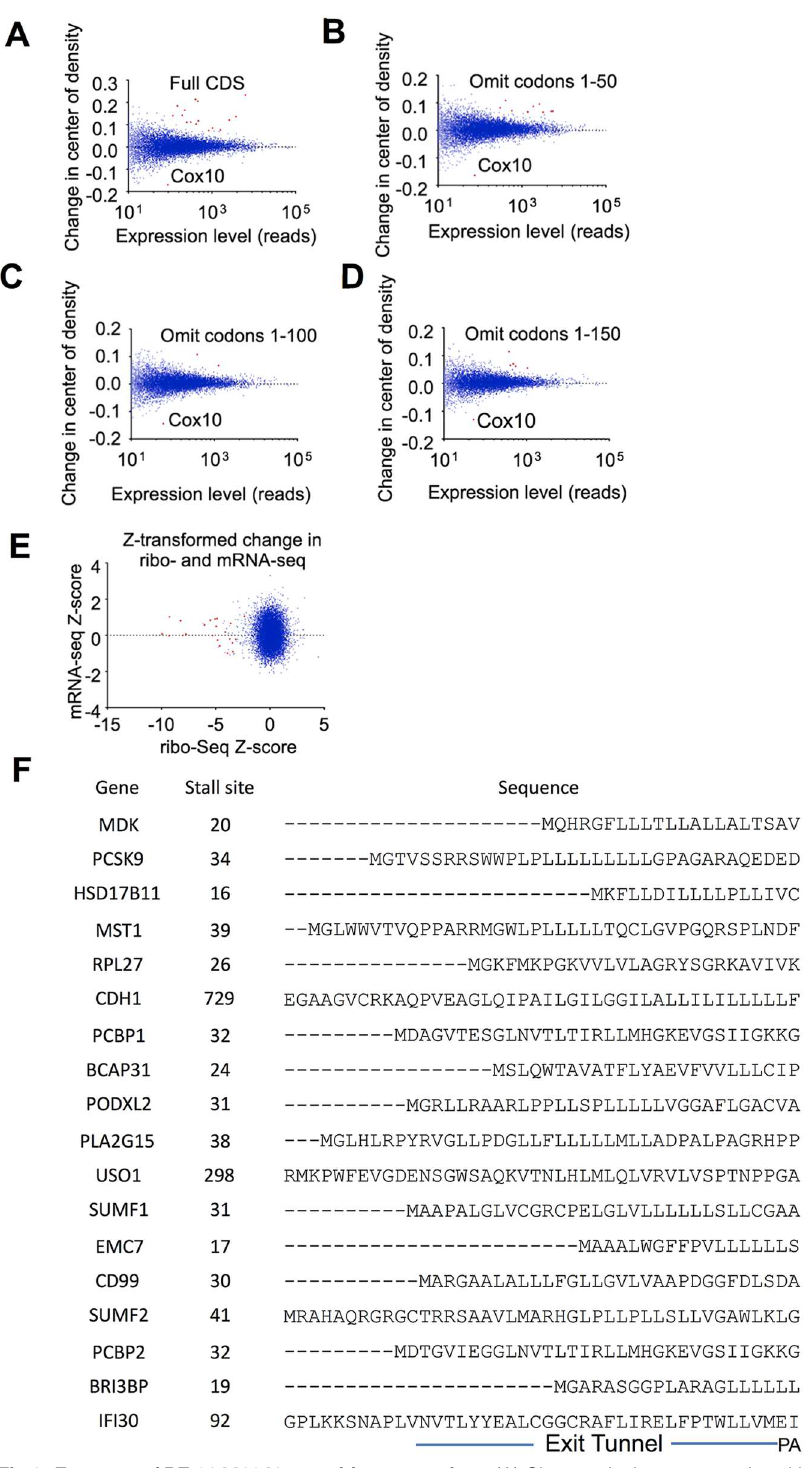
Fig 6. Features of PF-06446846–sensitive transcripts. (A) Changesin the mean read position or center of density [22] plotted against expressionlevels. Genes with a local Z-score greater than 3 are highlightedin red. (B–D) Center-of-density analysiswith first (B) 50, (C) 100, and (D) 150 codons omitted, showingthat stalling preferentially occurs before codon 50. (E) Expression changesfor PF-06446846–sensitivetranscripts